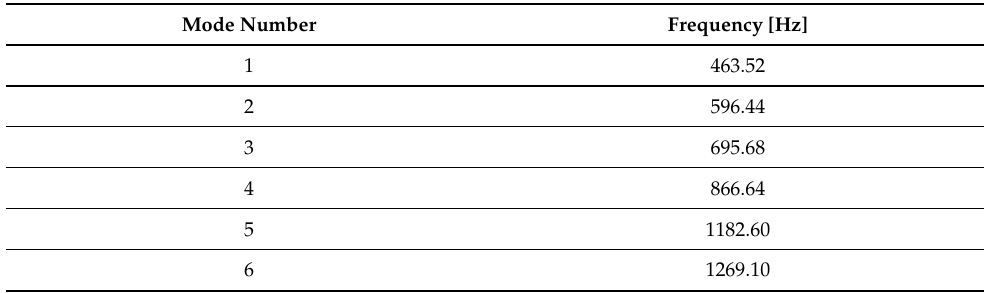
Figure 5. Discretization of the mechanism employed for the modal analysis. Table 1. Natural frequencies associated with the first six resonance